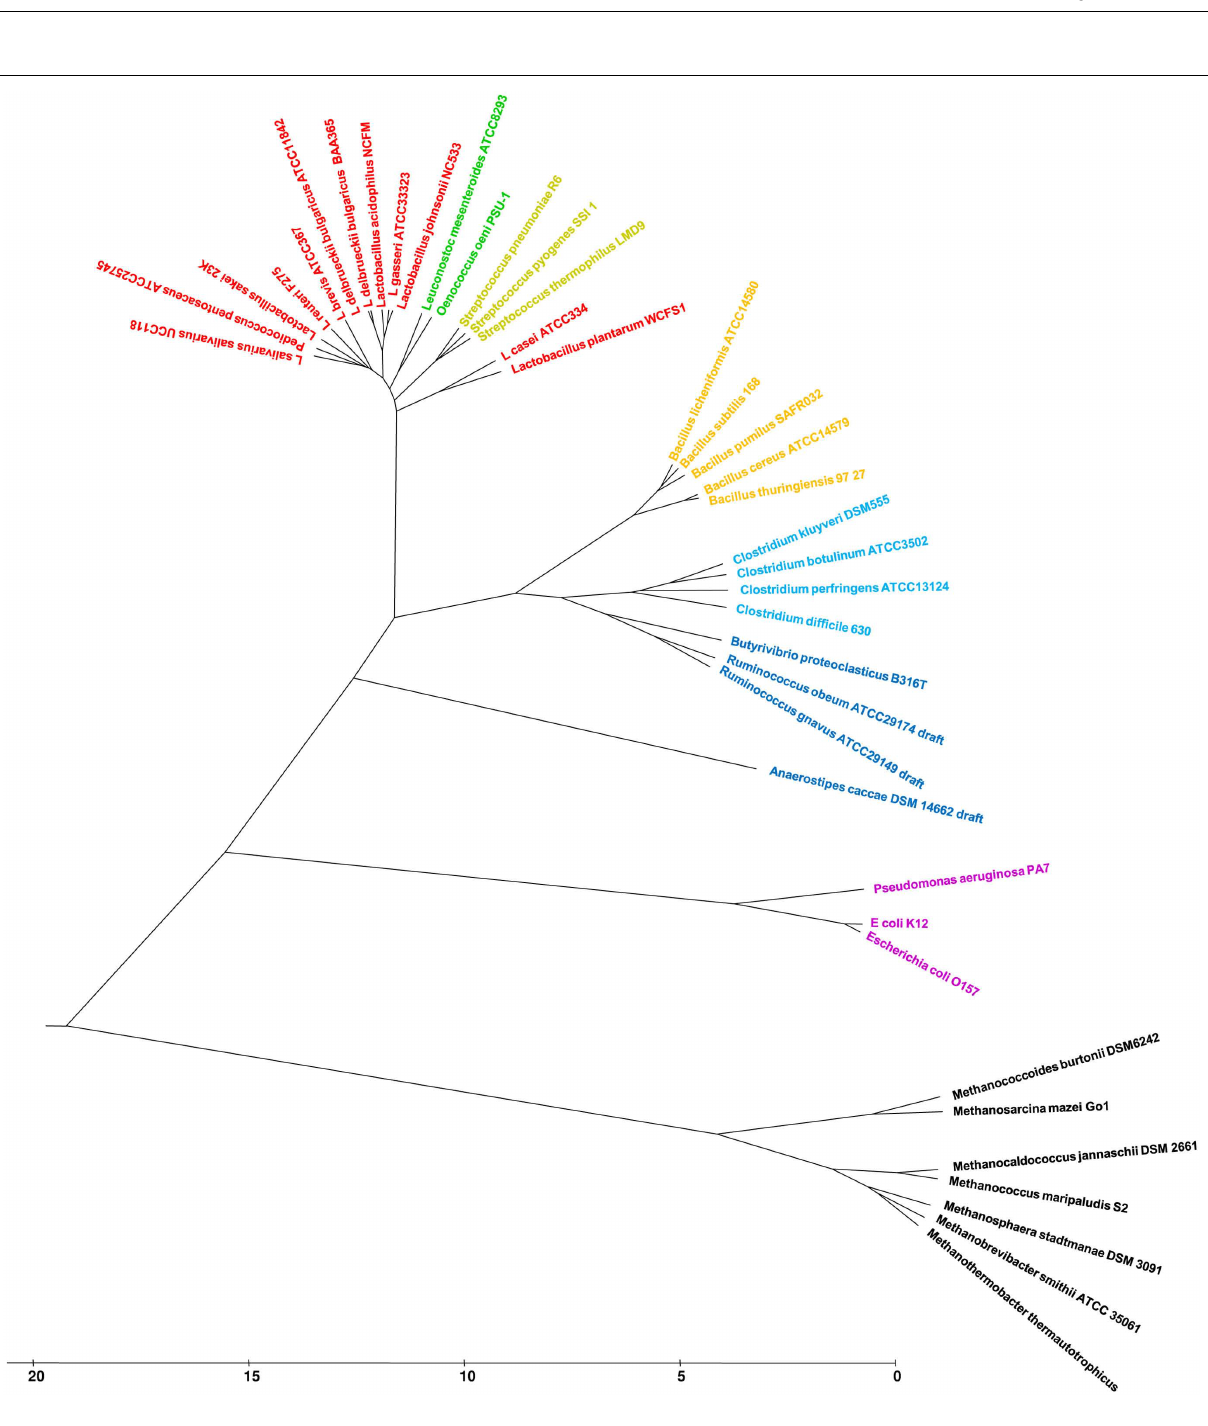
FIGURE 2 | Functional genome distribution of 39 taxa. Publicly available complete genomes were downloaded in GenBank format from the NCBI genome database. Publicly available draft phase genomes were downloaded in FASTA format, concatenated using a universal spacer-stop-spacer sequence and automatically annotated using GAMOLA (Altermann and Klaenhammer, 2003).The in-house draft phase genome of Butyrivibrio proteoclasticus was assembled into an artificial genome and annotated using GAMOLA